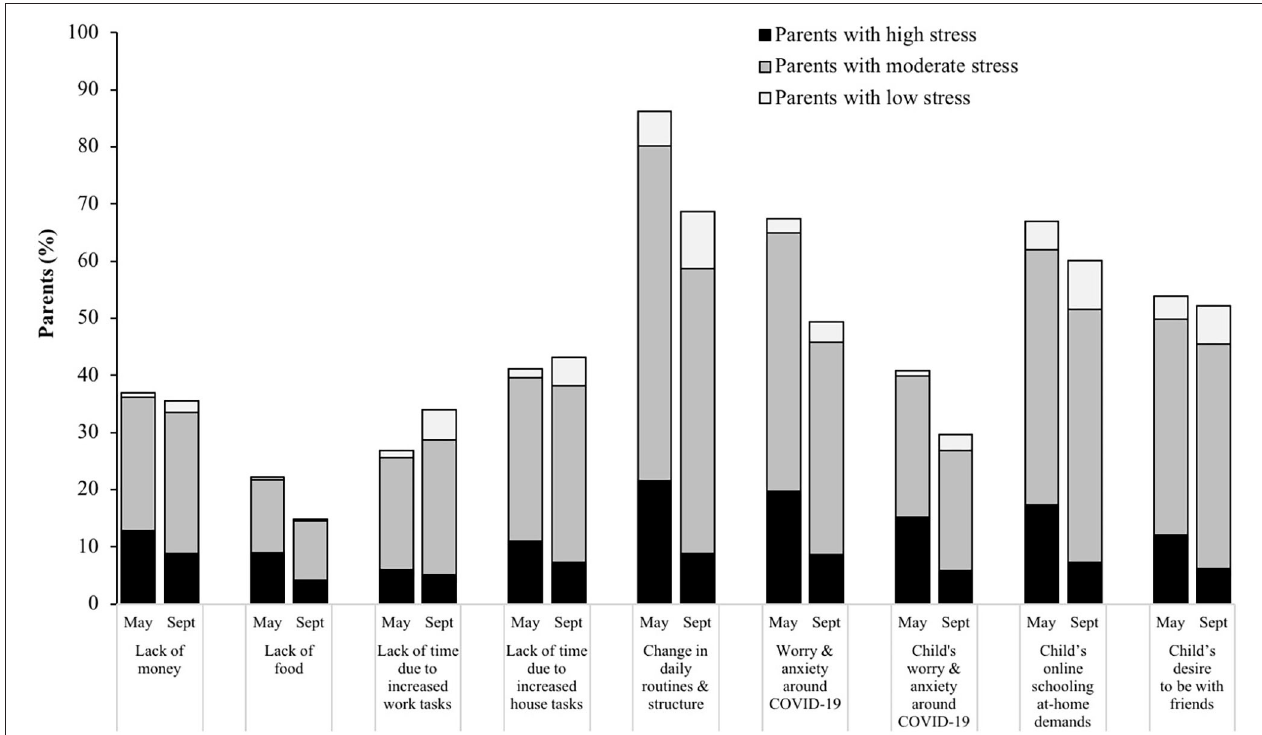
FIGURE 2 | Pandemic-related factors that parents reported as having impacted their parenting during COVID-19 in May and September 2020, illustrated by parent-reported stress levels (low, moderate, or high) at that corresponding timepoint. Data collected in a nationwide sample of US parents with a child 5–18 years of age ( N = 433). Parents could have selected more than one